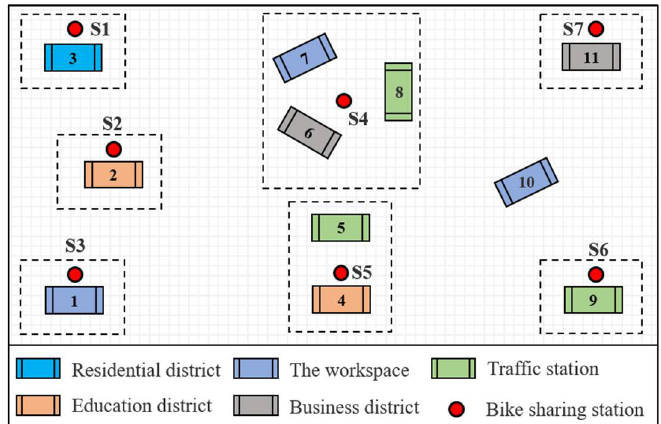
Figure 4. Spatial relationship of various places and docking stations of public